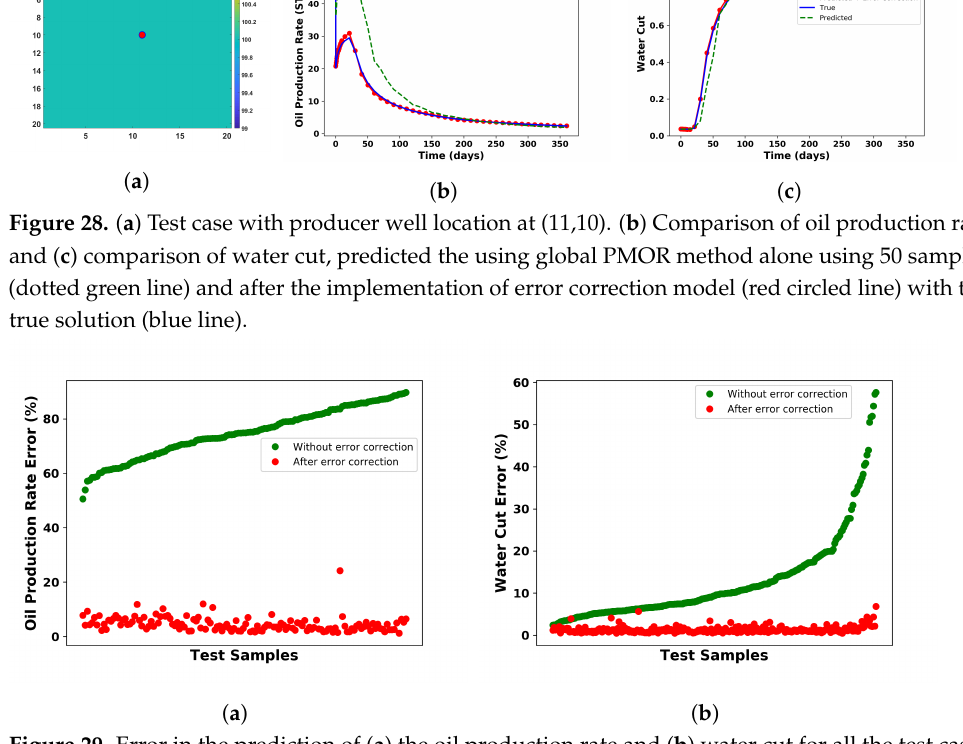
Figure 29. Error in the prediction of ( a ) the oil production rate and ( b ) water cut for all the test cases before and after the error correction of the solutions. Table 6. Homogeneous reservoir case 2: Average accuracy of the oil production rate and water cut for all test